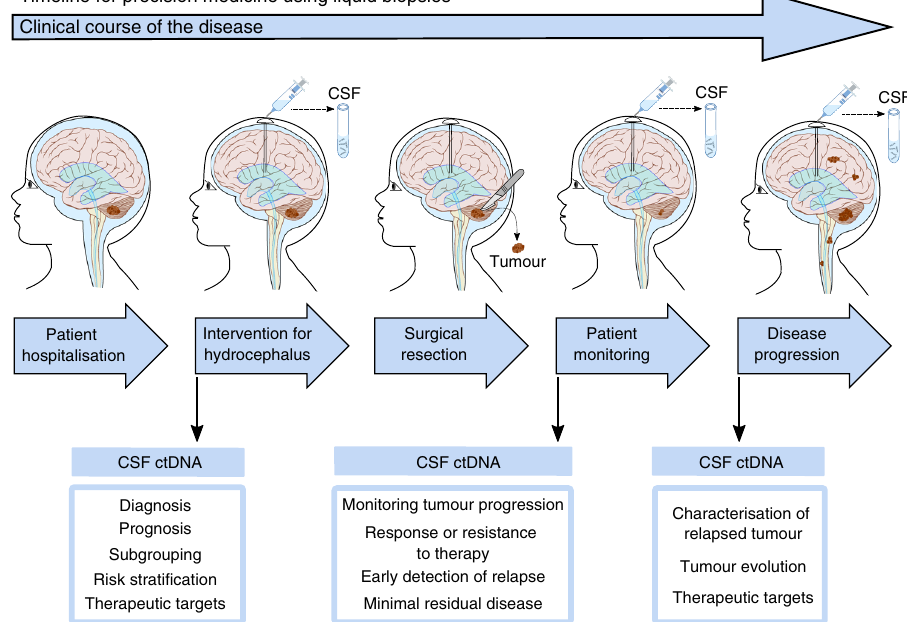
Fig. 6 Proposed strategy to improve the clinical management of paediatric patients with MB using liquid biopsies. At the time of patient hospitalisation, MRI allows the detection of hydrocephalus and the brain tumour. CSF drainage is required for patients with hydrocephalus and the CSF sample can be used for WES of ctDNA. The analysis of CSF ctDNA identi fi es mutations, CNVs, arm-level and chromosome gain/loss and the frequency of somatic mutations. The genomic characterisation of the cancer provides information about MB-subgroup and the risk strati fi cation, that is critical for the diagnosis and prognosis. In addition, therapeutic targets can be identi fi ed from the analysis of CSF ctDNA. The information obtained from the CSF ctDNA can guide the surgical resection, identifying those patients for which residual disease is a risk modi fi er and confers worse prognosis. Analysis of follow-up CSF samples could complement the MRI to identify minimal residual disease or early detection of relapse. Improving the monitoring of tumour progression and identifying response or resistance to therapeutic targets. Importantly, if disease progression is identi fi ed, analysis of CSF ctDNA can characterise the relapsed tumour, providing information about the diagnosis, prognosis and potential therapeutic targets. This will be extremely critical for patients with disseminated disease so the therapeutic strategy can be adjusted. Moreover, the comparison of CSF ctDNA from primary with refractory disease would provide information about the emergence of secondary tumours. The study of tumour heterogeneity and cancer evolution would reveal mechanisms of resistance and aid in the discovery of therapeutic targets for MB. Altogether, the analysis of CSF ctDNA can aid in the clinical management of patients and provide information about relapse to advance research towards precision